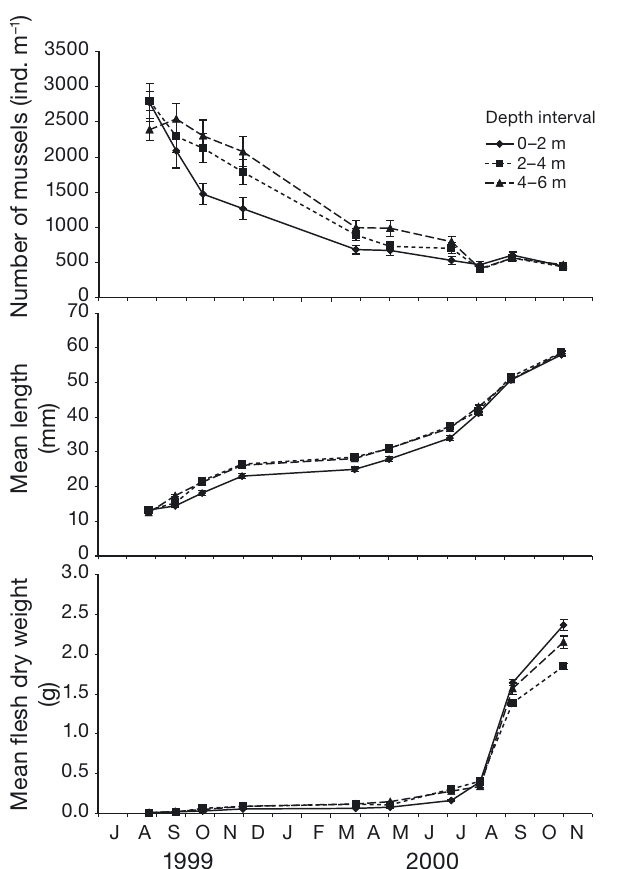
Fig. 9. Measured mean abundance, mean individual length and mean individual dry weight of body parts of mussels